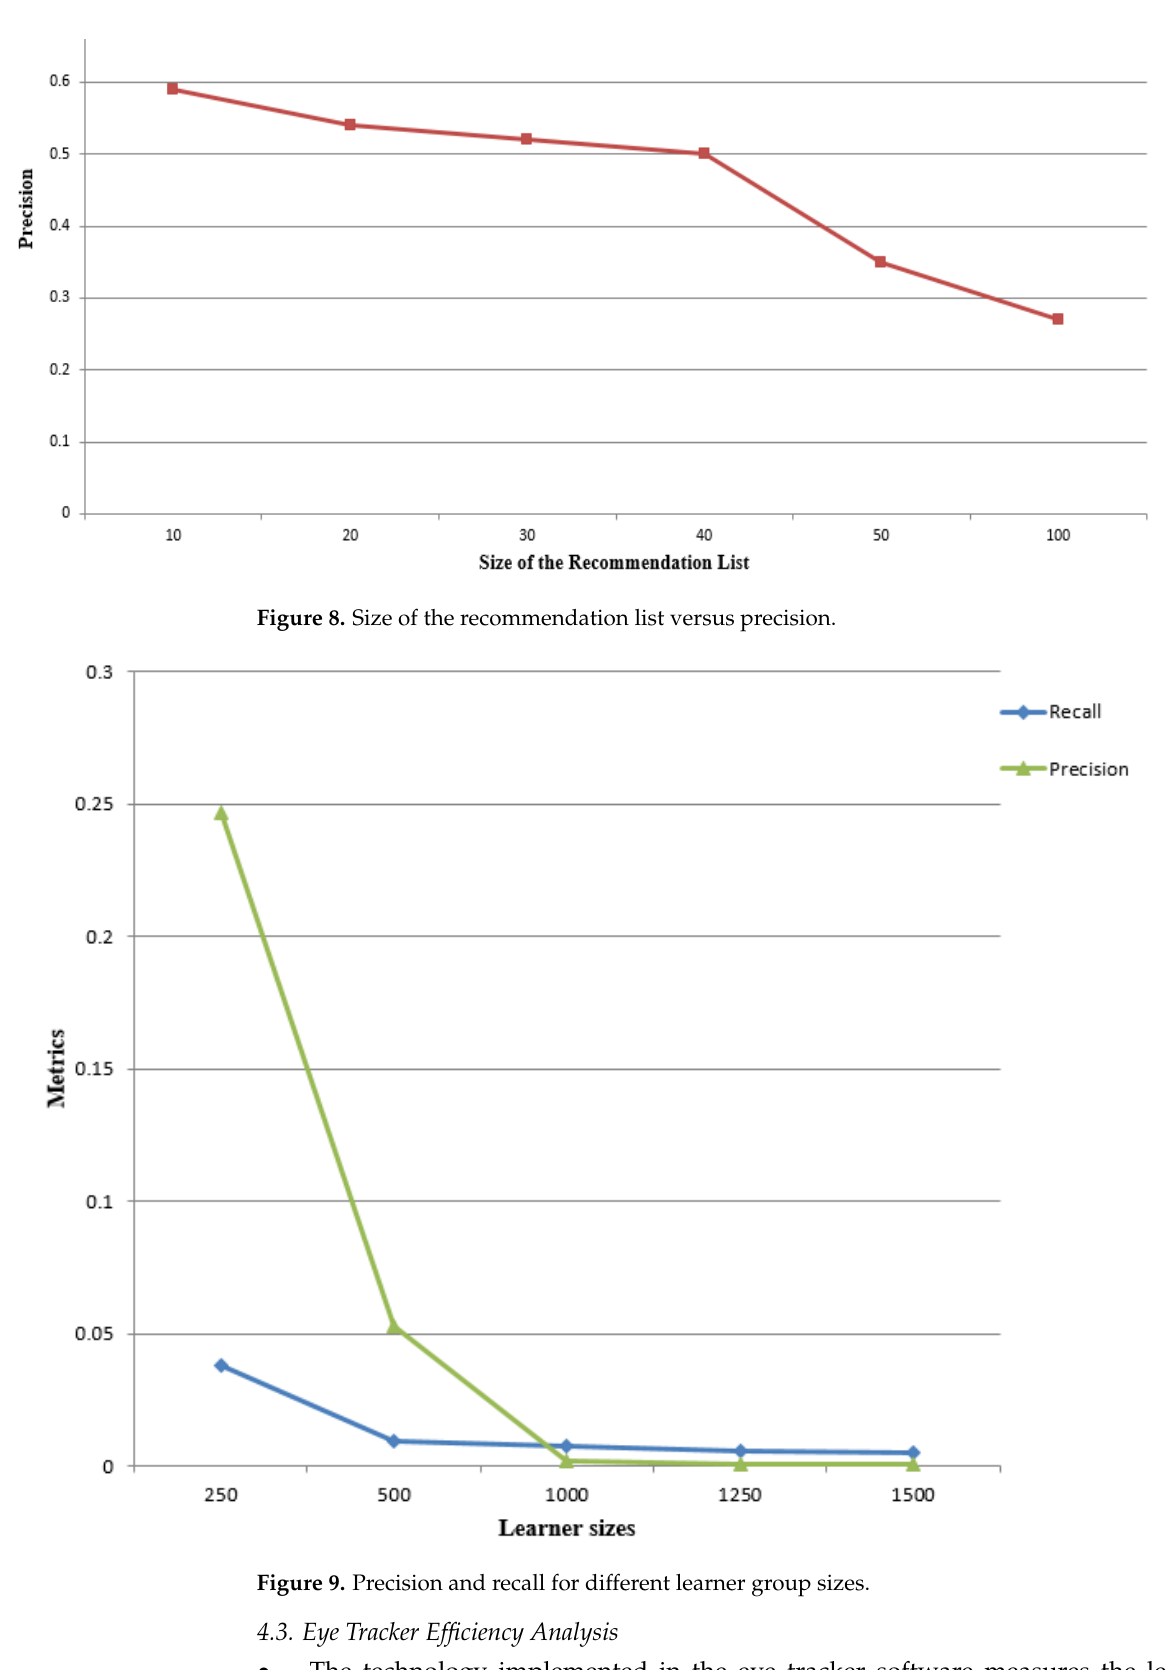
Figure 7. RMSE for different learner group sizes.